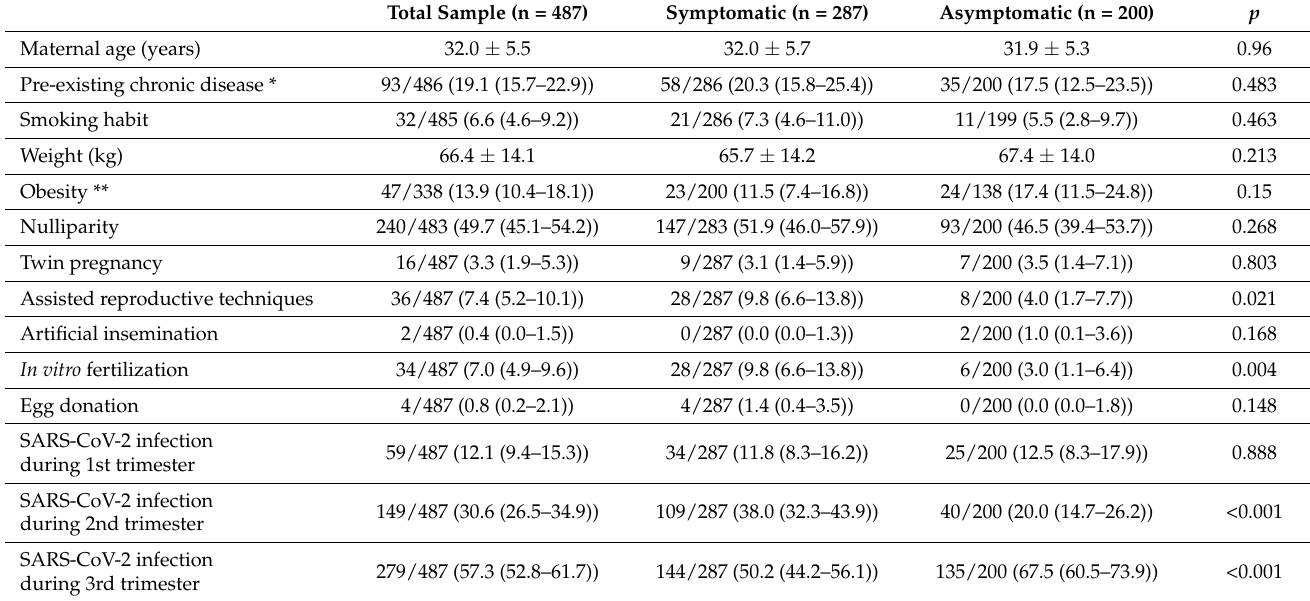
Table 1. Pregnant women with SARS-CoV-2 infection, overall and according to the presence of symptoms.